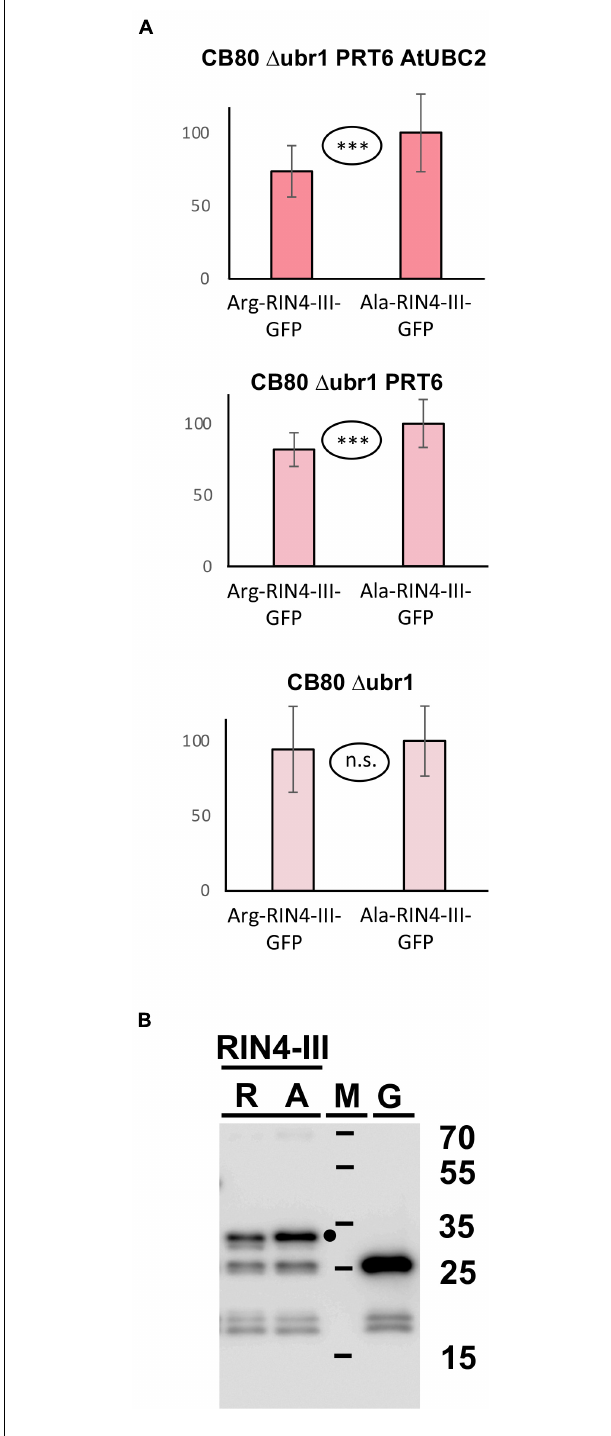
FIGURE 7 | (A) Steady-state levels of Arabidopsis protein fragment RIN4-III fused to GFP in different yeast strains. The protein starts either with Arg, or with Ala (see Figure 3 and text for protein processing steps, Supplementary File 3 for amino acid sequences and Supplementary File 6 for numerical data). Mean abundance of the protein starting with Ala was set 100%. Standard deviations are shown as error bars. Measurements were carried out